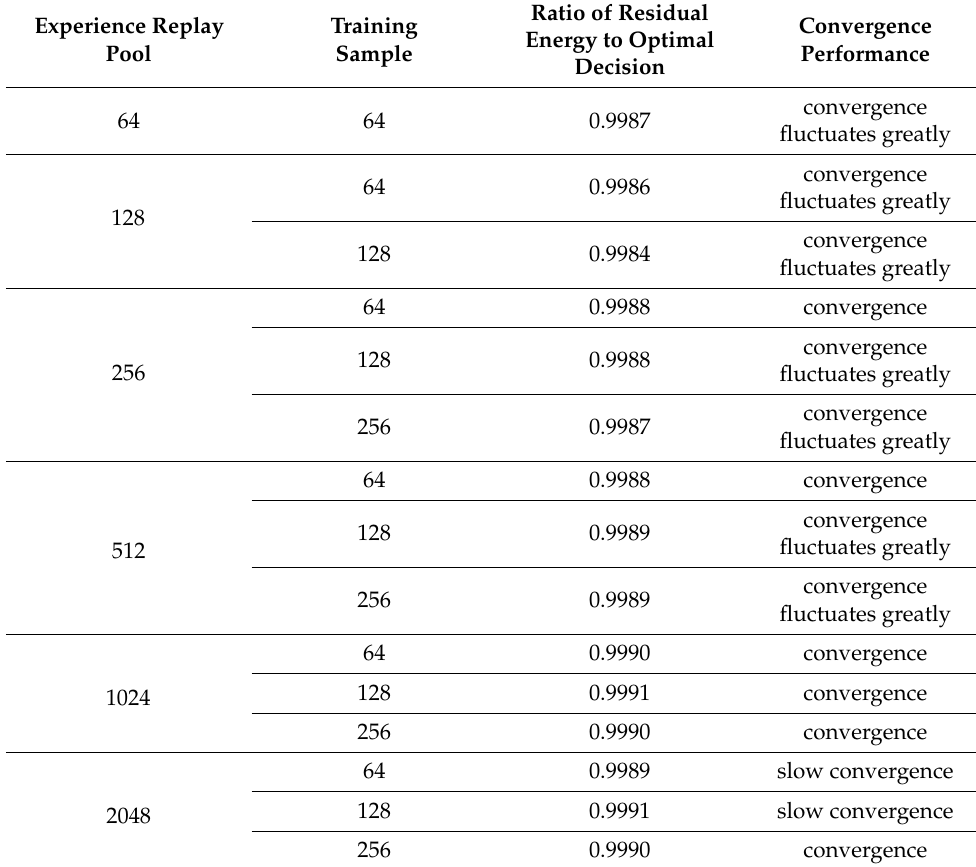
Table 2. The effect of experience replay pool size on algorithm performance. Here, we set N =